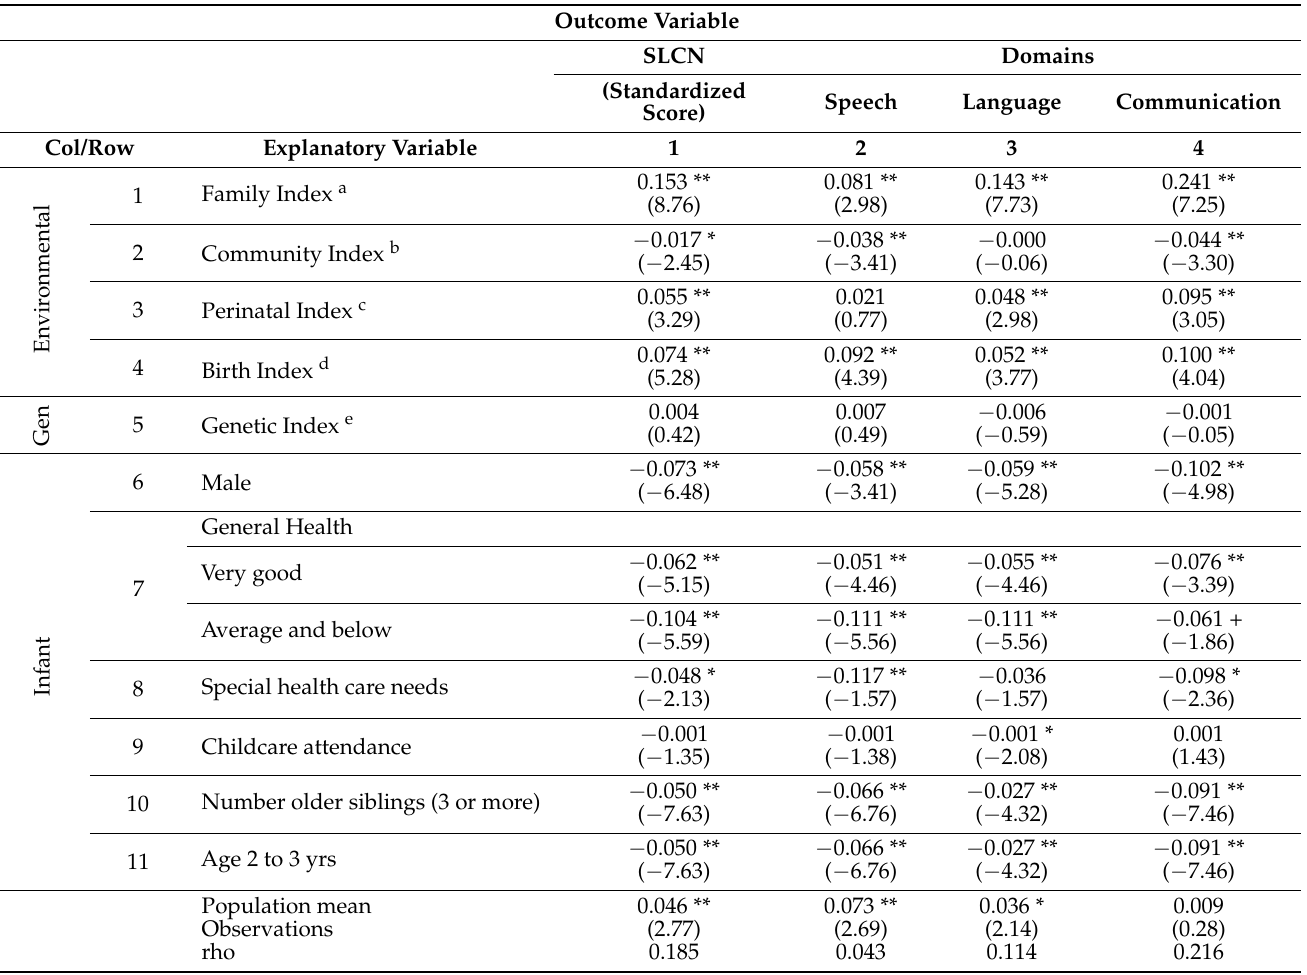
Table 2. SLCN Regression